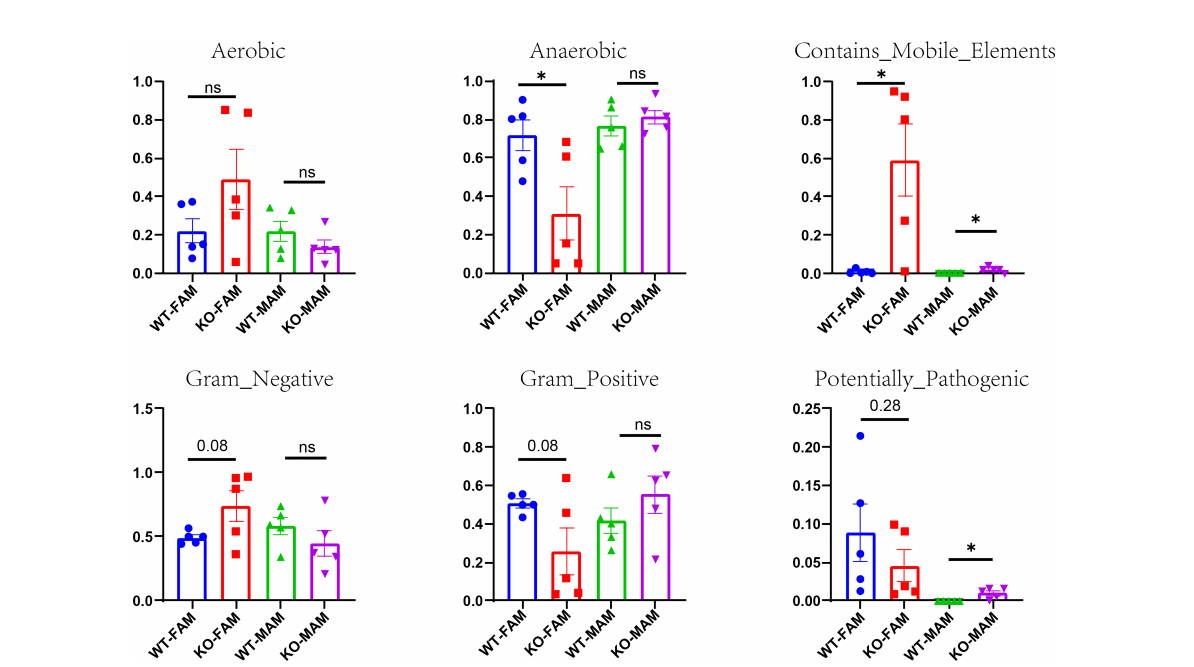
FIGURE 7 Potential phenotypes (aerobic, anaerobic, containing mobile elements, Gram-negative, Gram-positive, and potentially pathogenic) of two groups in FAM and MAM. *p < 0.05, ns, no signi fi